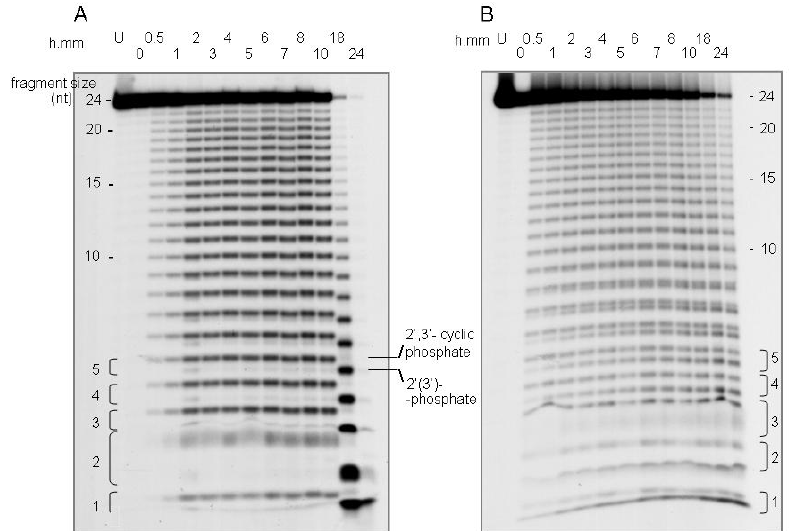
Figure 2. Instability of RNA oligonucleotides in water and in